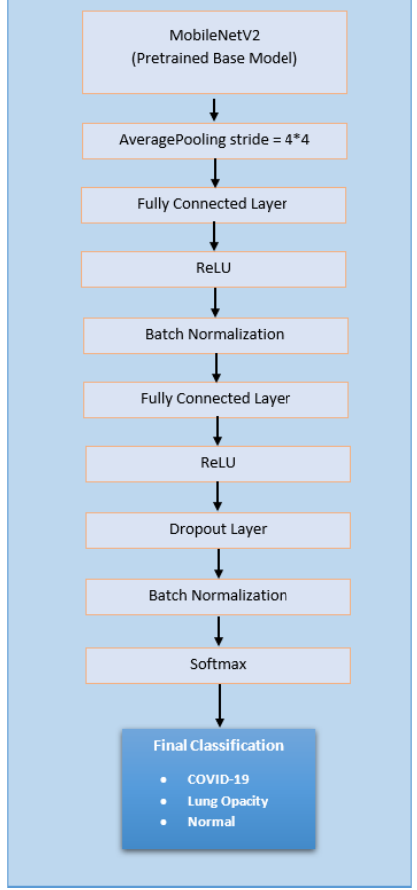
Figure 5. Deep learning Model-1 (extended Mobilenetv2 model).